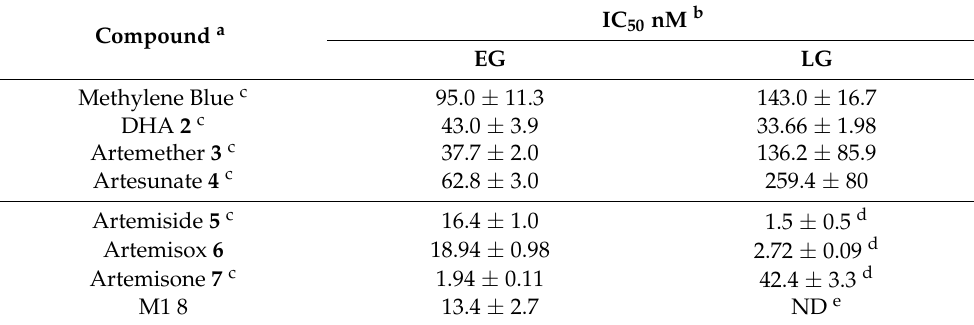
Table 2. Activities in vitro against early-(EG) and late-(LG) blood stage Pf NF54